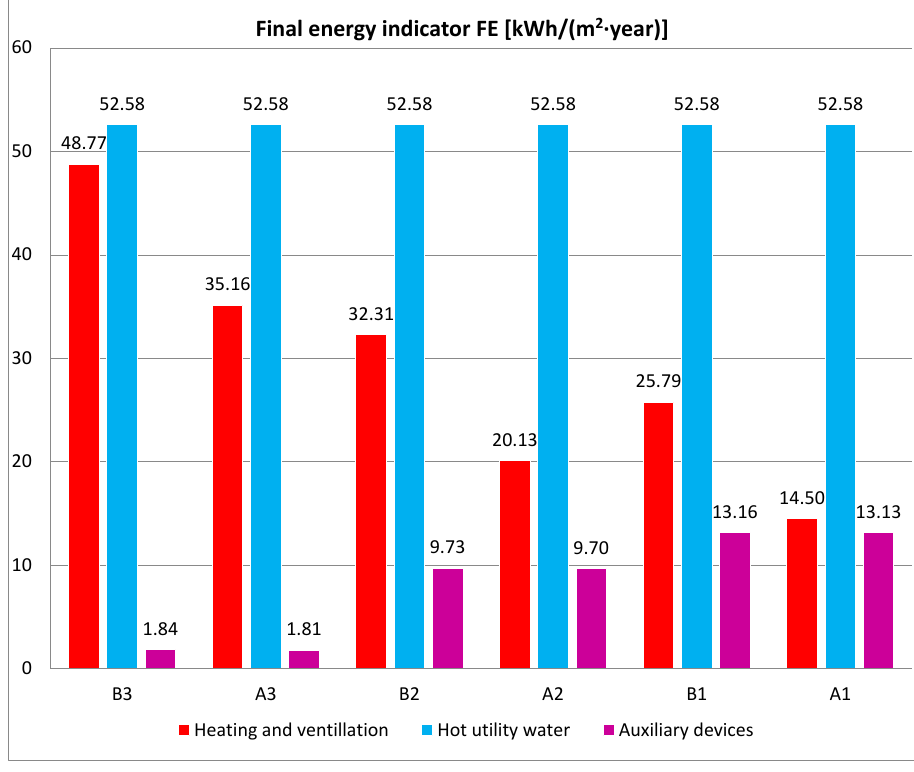
Scheme 2. Comparison of FE indicators for a building of a different energy class for the heat source: the gas boiler room.